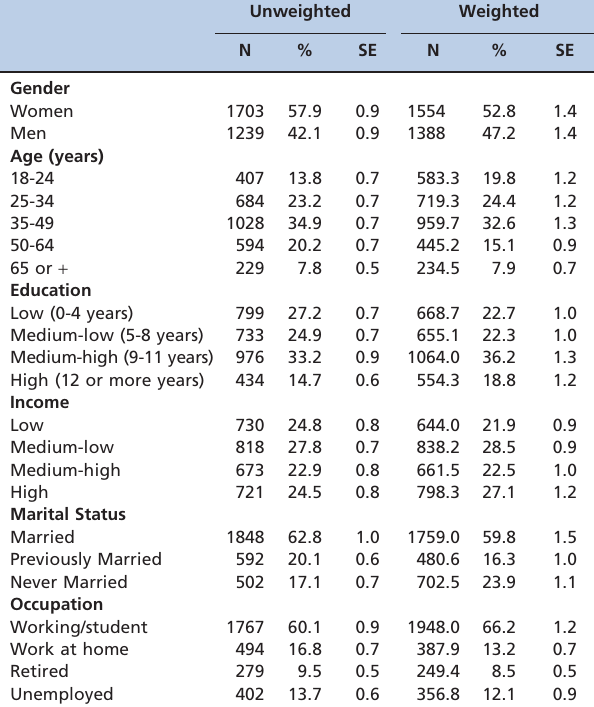
Table 1 - Demographic characteristics of the Sa˜o Paulo Megacity Mental Health Survey sample (n=